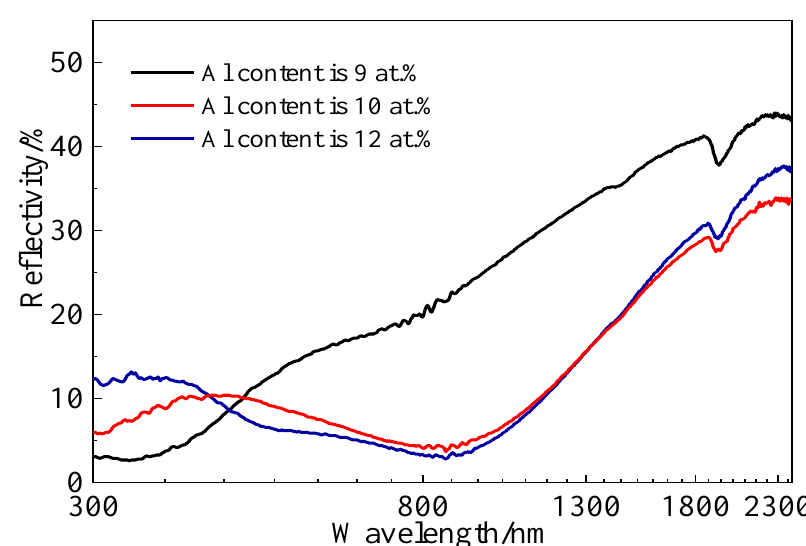
Figure 11. Effect of Al content on reflectivity of TiMoAlON selective absorbing films.